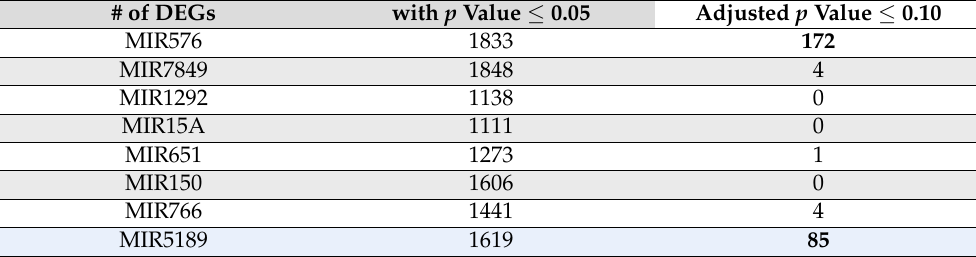
Table 4. Numbers of PBMC mRNA where expression correlates with select miRNA plasma